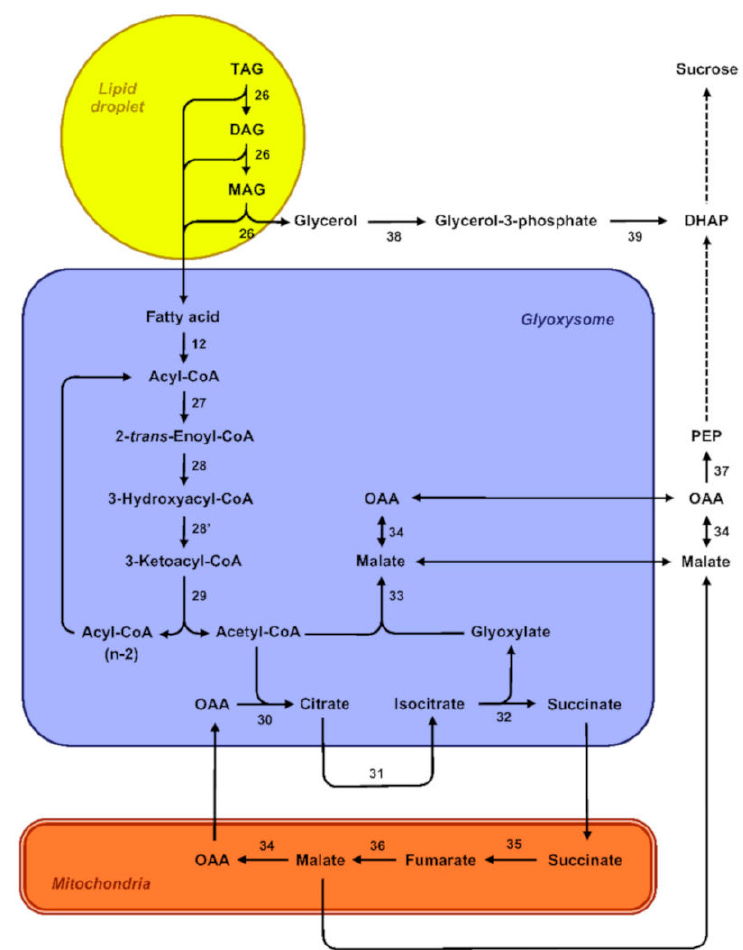
Figure 4. Overview of oil metabolism in germinating seeds. The scheme depicts the different pathways involved in the mobilization of storage lipids in germinating seeds. 12, long-chain acyl-CoA synthetase; 26, triacylglycerol lipase; 27, acyl- CoA oxidase; 28, multifunctional protein 2- trans -enoyl-CoA hydratase; 28 (cid:48) , multifunctional protein 1,3-hydroxyacyl-CoA dehydrogenase; 29, 3-ketoacyl-CoA thiolase; 30, citrate synthase; 31, aconitase; 32, isocitrate lyase; 33, malate synthase; 34, malate dehydrogenase; 35, succinate dehydrogenase; 36, fumarase; 37, phosphoenolpyruvate carboxykinase; 38, glycerol kinase; 39, glycerol-3-phosphate dehydrogenase. Abbreviations: CoA, coenzyme A; DAG, diacylglycerol; FA, fatty acid; MAG, monoacylglycerol; TAG,